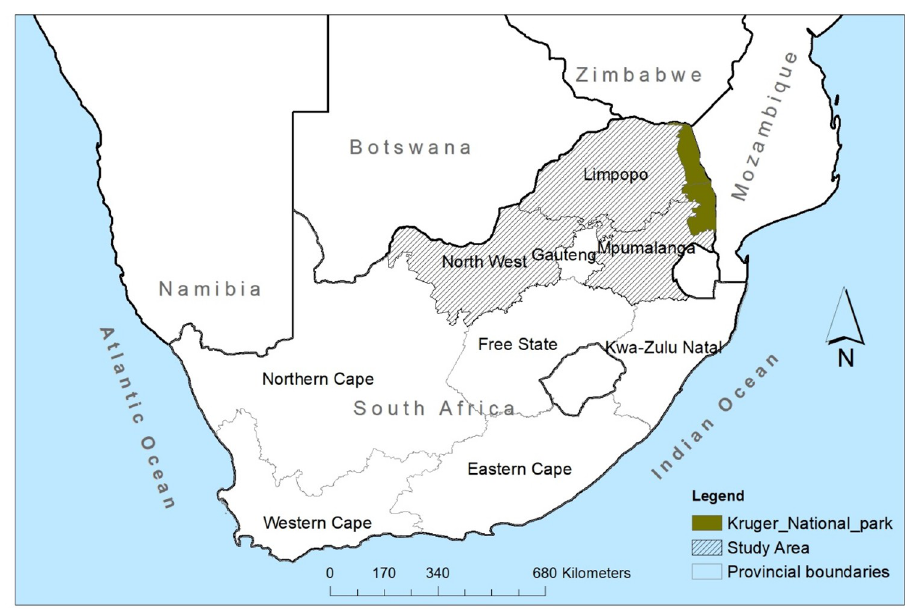
Fig 1. Map showing the provinces of South Africa and study areas. < https://dataportal-mdb-sa.opendata.arcgis. com/ > .